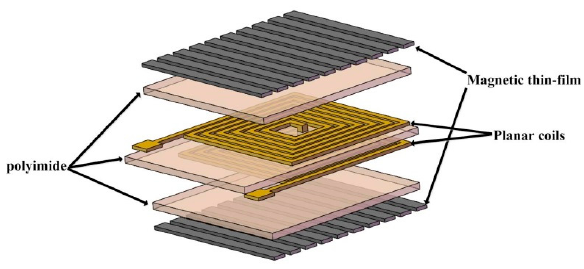
Figure 1. Structure of planar inductor with patterned magnetic film.